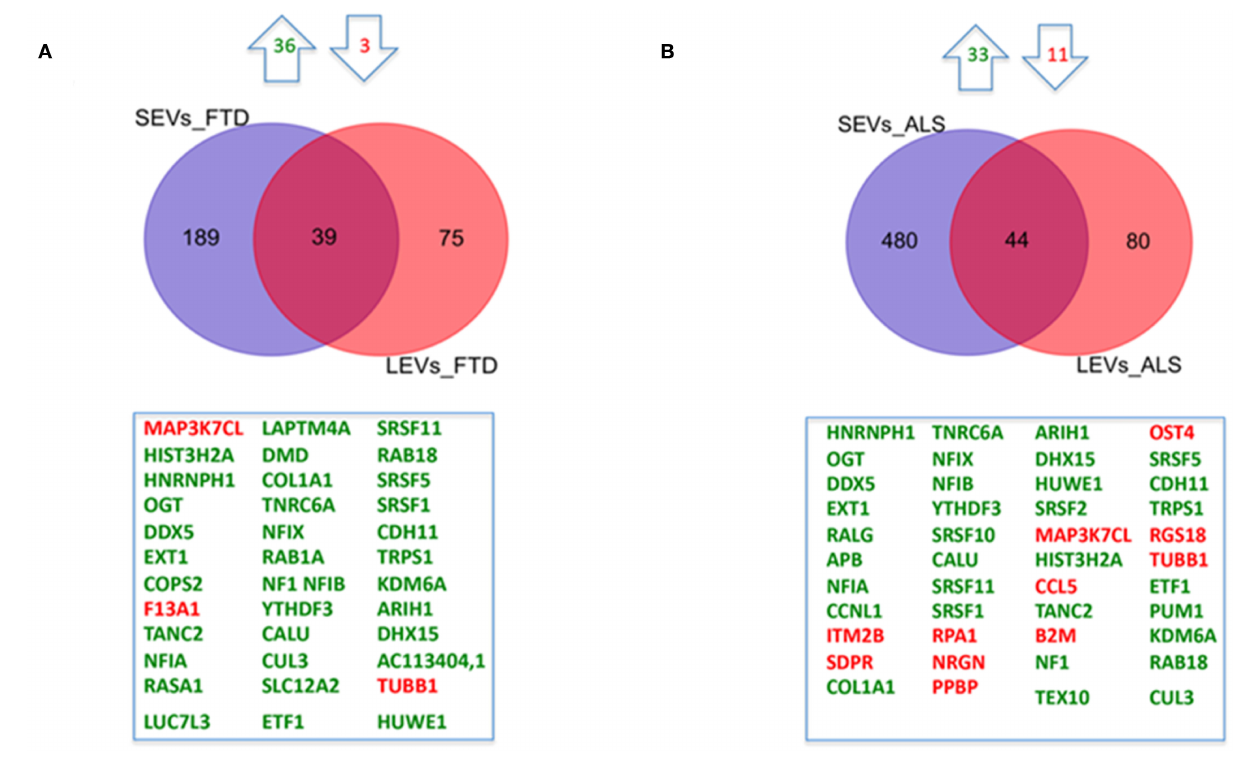
FIGURE 1 | Common packaging of deregulated mRNAs into small extracellular vesicles (SEVs) and large extracellular vesicles (LEVs) from patients with frontotemporal dementia (FTD) and amyotrophic lateral sclerosis (ALS). (A) For FTD, of the 228 mRNA in SEVs and 114 in LEVs, 39 were in common (i.e., 36 upregulated, green, and 3 downregulated, red). (B) For ALS, of the 522 mRNA in SEVs and 124 in LEVs, 44 were in common (i.e., 33 upregulated and 11 downregulated). Differential mRNA expression analysis was carried out using DESeq2 (log2FC > 1, p < 0.05).